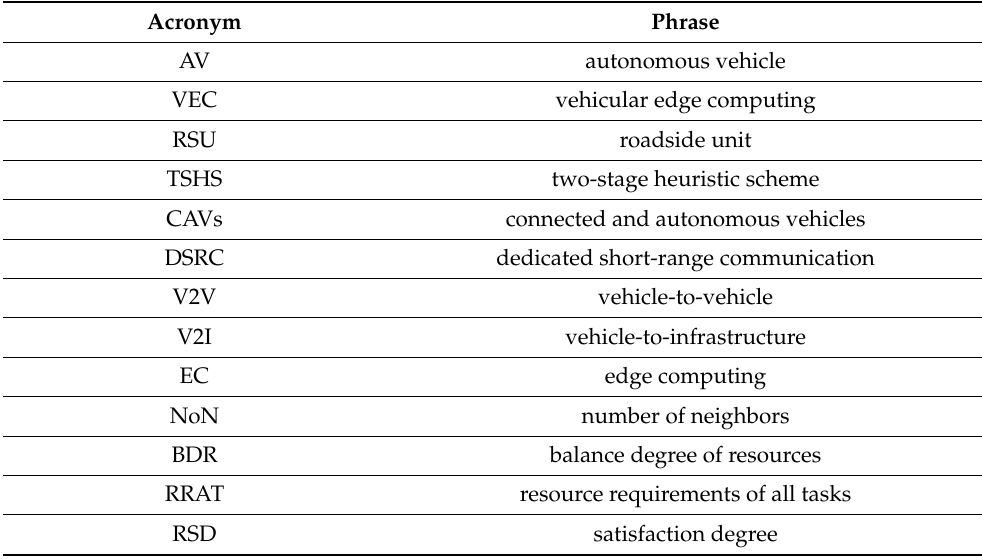
Table 1. Summary of